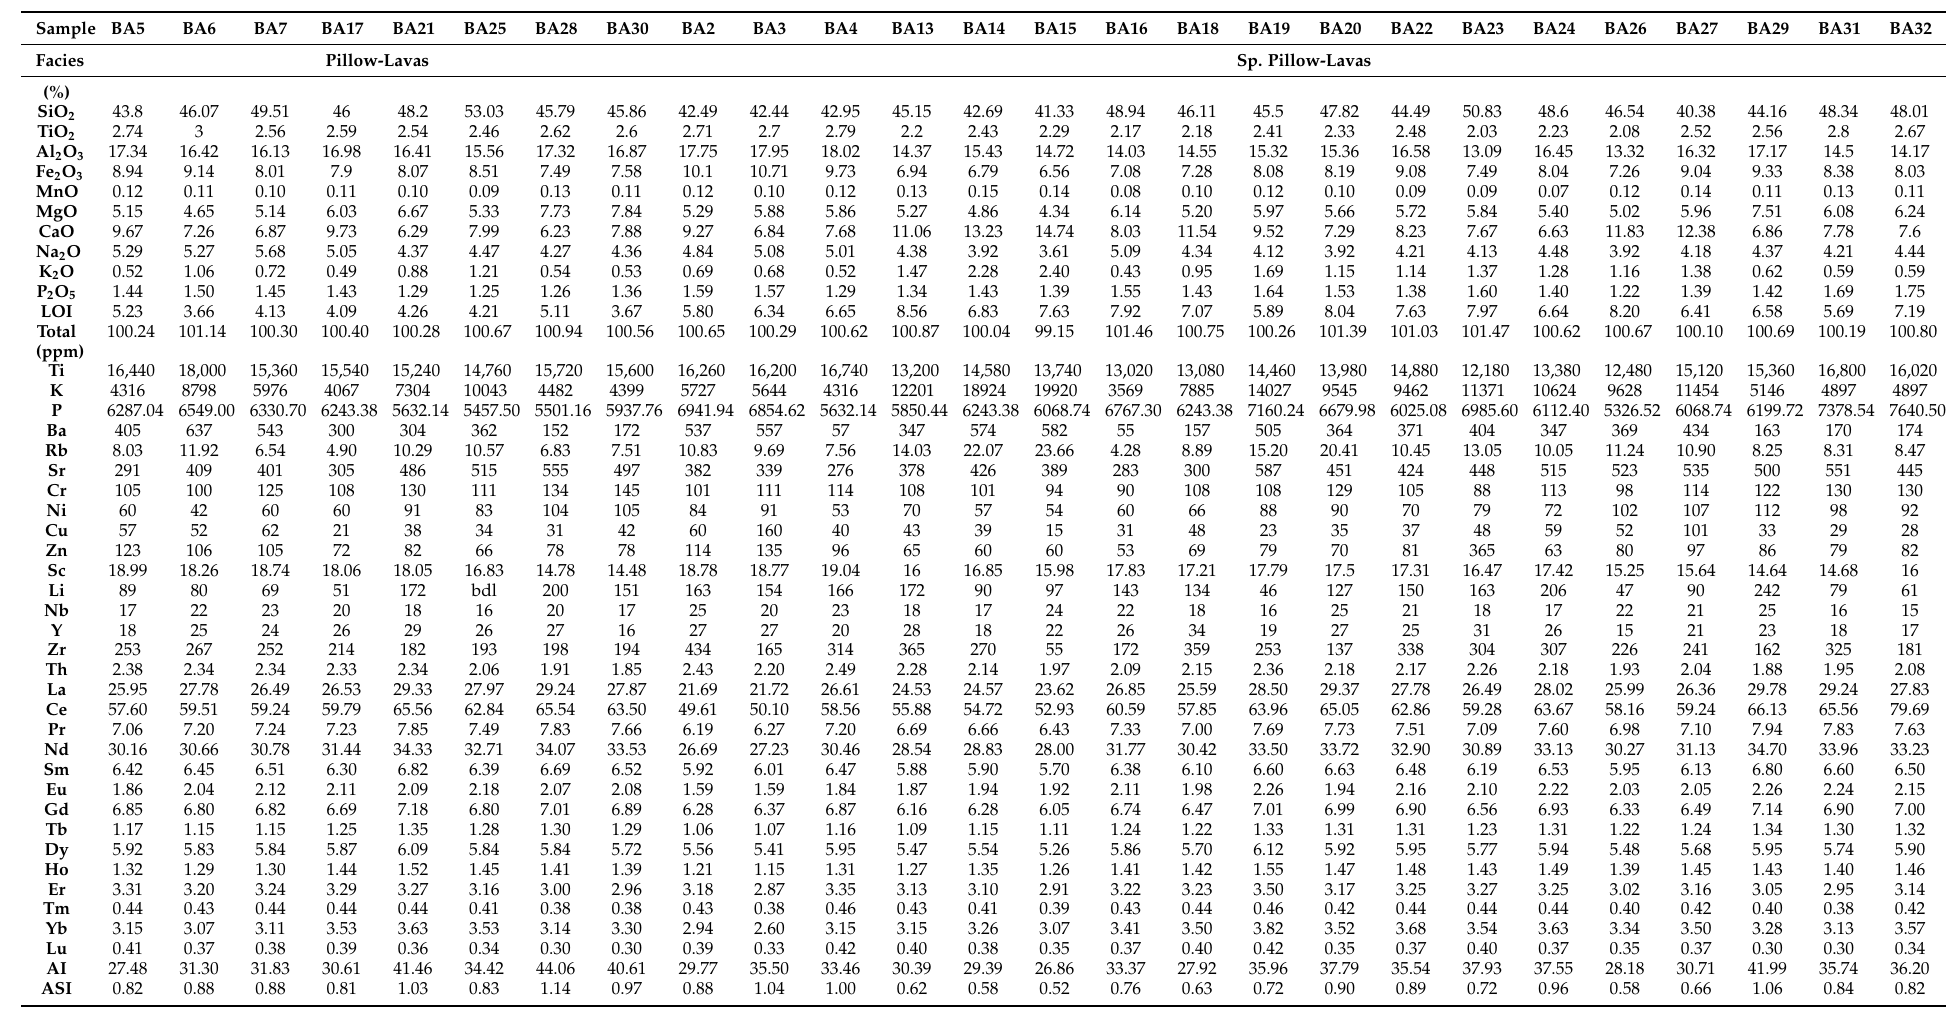
Table 1. Chemical analyses of the major, trace and rare earth elements of interstratified pillow-lavas in the Upper Carboniferous series of the NNE Achemmach. bdl: below detection limit. Sp.Pillow-lavas: splitized pillow